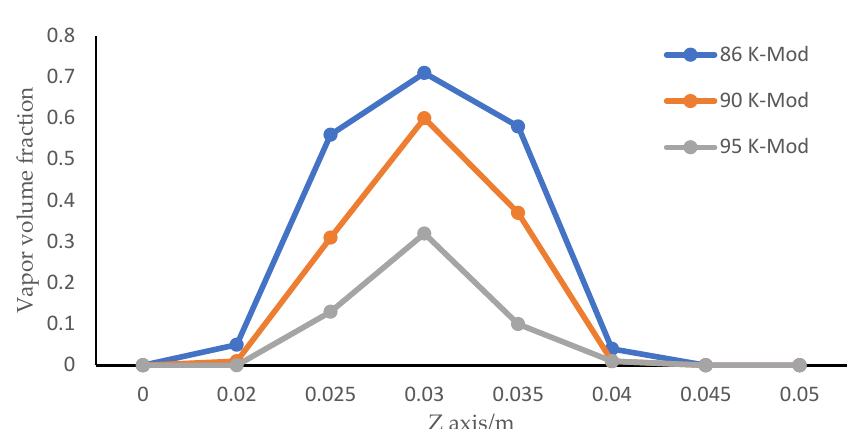
Figure 15. Volume fraction distribution of liquid oxygen in the inducer in the Zwart modified. cavitation model.